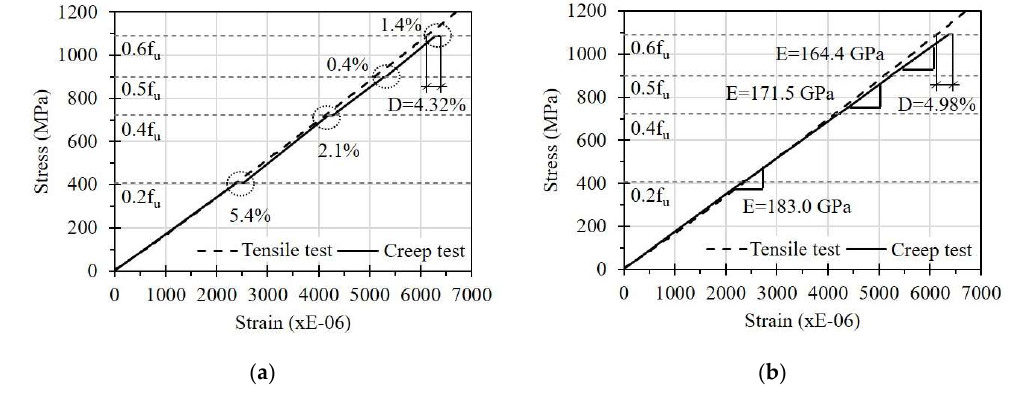
Figure 11. Creep effect on the FRP strip: ( a ) The E specimen; ( b ) The C specimen. From the graphs, it can be seen that the FRP strip was affected by sustained stress. In detail, the strain on the FRP strip in the E specimen increased by 5.4% due to the creep effect after applying a sustained stress of 0.2f u for 28 days (see Figure 11a). In addition, strain increases due to creep effects were observed after loading for 7 days each at 0.4f u